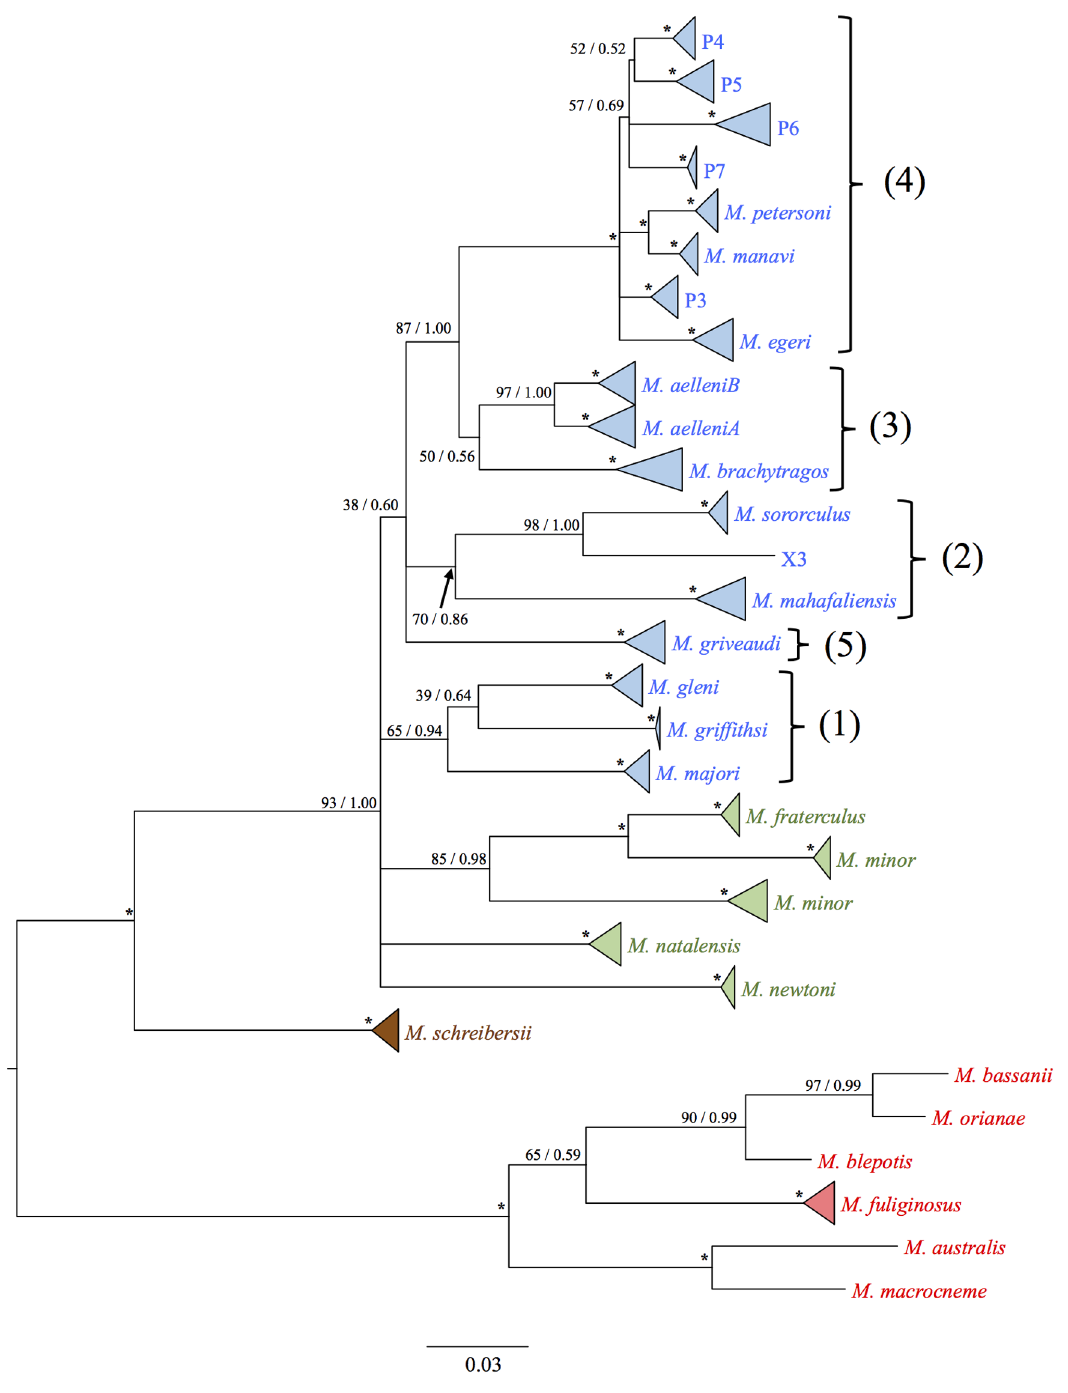
Figure 2. Bayesian majority consensus tree based on cvt- b sequence data and according to a HKY + G nucleotide substitution model. The first number at each node represents bootstrap support according to the Maximum Likelihood analysis; the second represents Bayesian posterior probability. An asterisk (*) at a node indicates full support from both analyses, i.e. 100/1.00. Where clades contain more than a single individual, these have been collapsed into triangles. Colour coding refers to the origin of the species, as follows: Blue = Madagascar; Green = Africa; Brown = Europe; Red = Asia and Australasia. Large bold numbers beside lineages indicate the five primary lineages referred to in the text. doi:10.1371/journal.pone.0092440.g002 represent either two separate colonization events or a single event that was followed by early divergence. Current data does not allow for the rejection of either of these hypotheses.